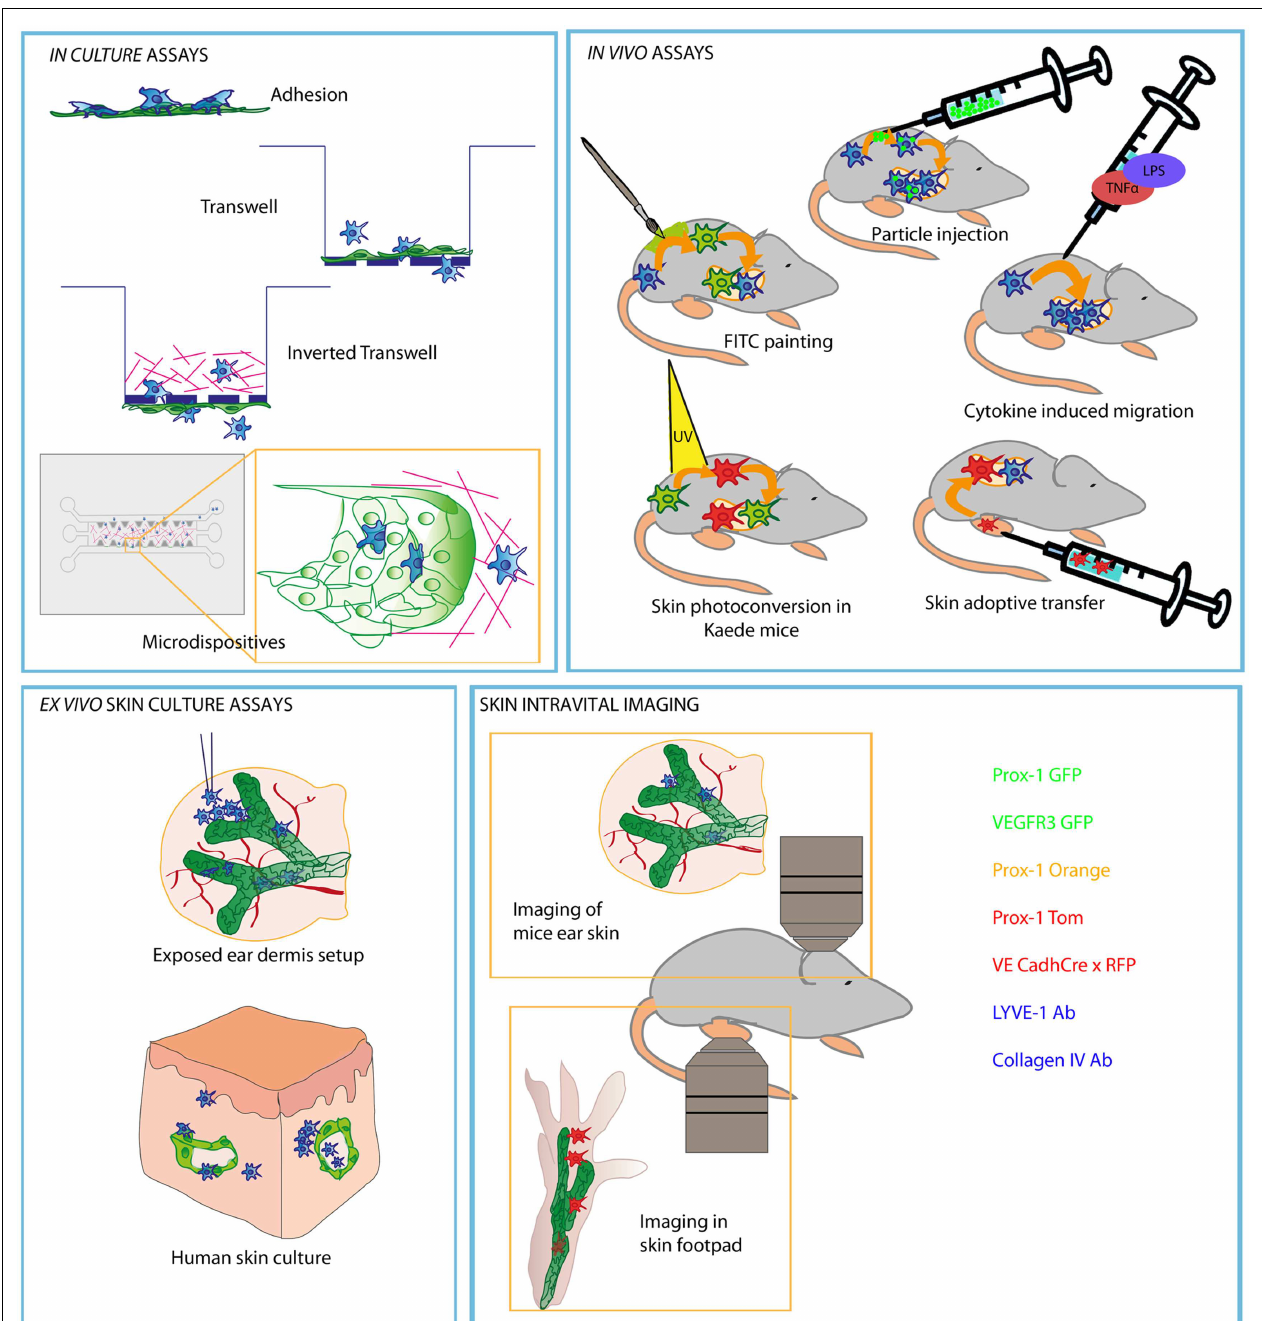
strategy and approach of each experiment. Lymphatic endothelial cells are represented in green and DC in blue (red or green when represented as